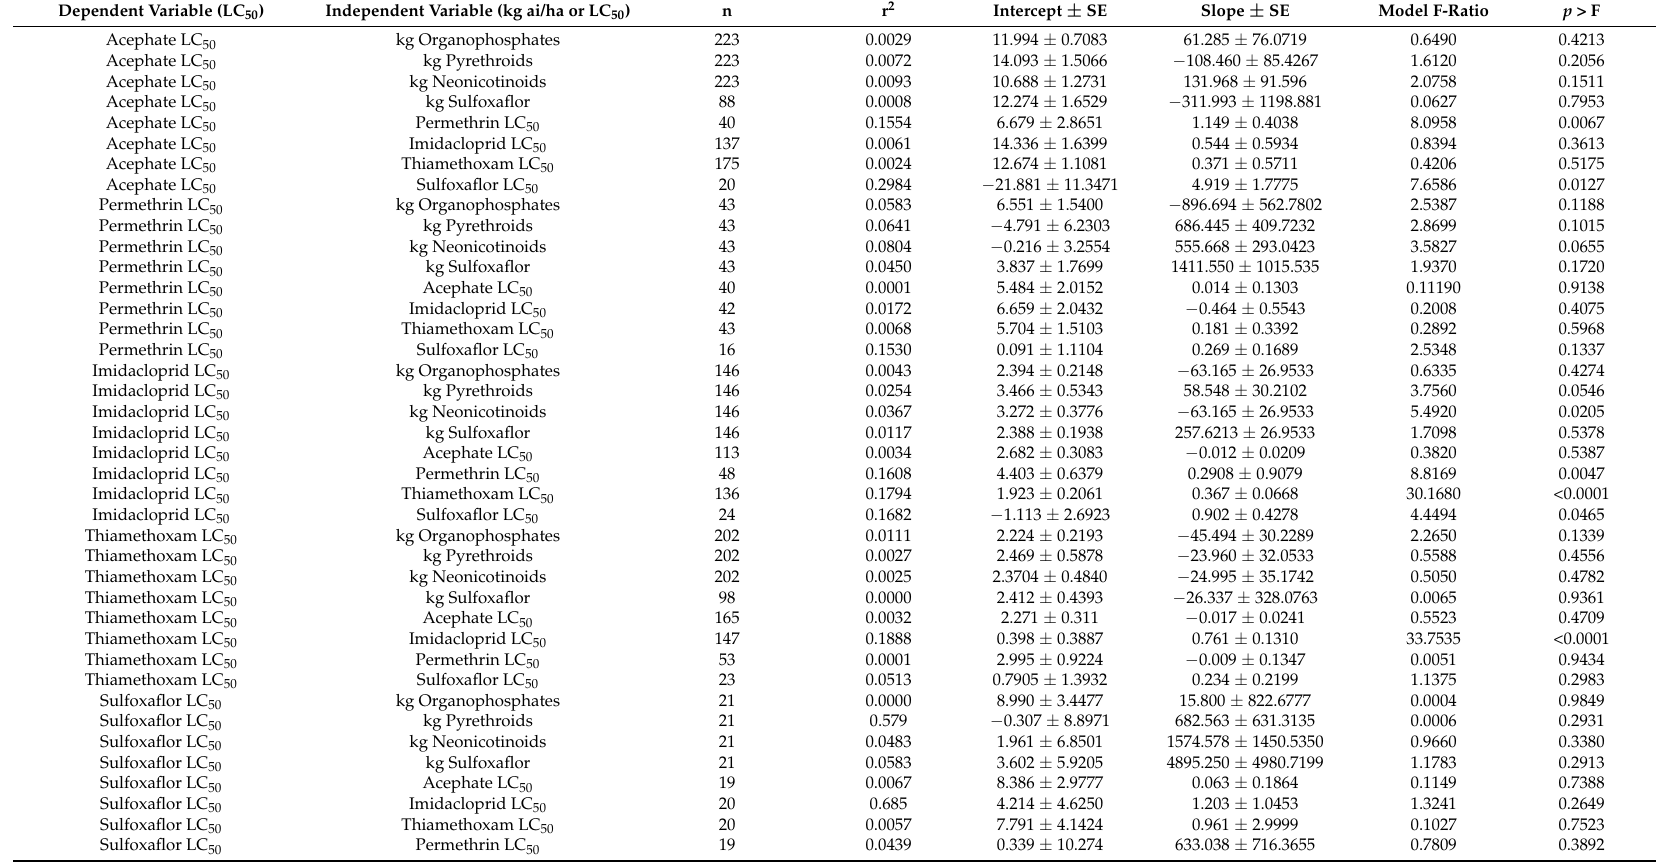
Table 8. Relationships between measured LC 50 s and estimated insecticide use (kg ai/ha harvested cropland) across all individual county-date